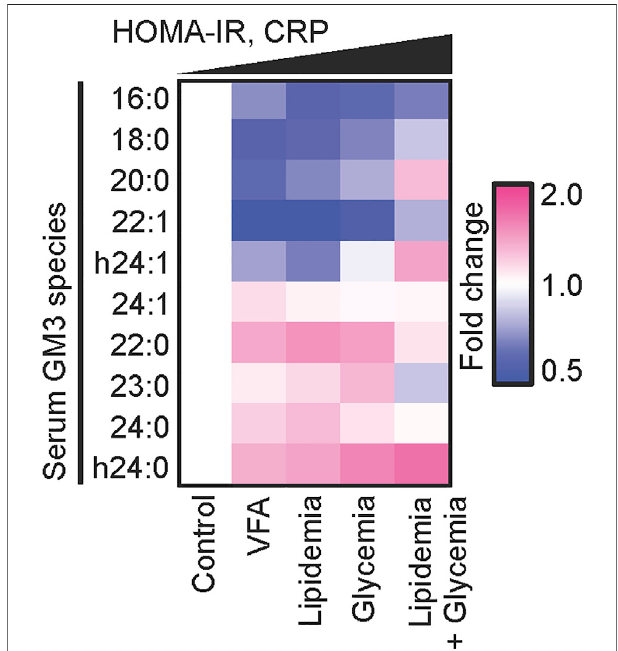
FIGURE 6 | Disease progression and chronic in fl ammation involve alterations of GM3 species composition. Heat map analysis of serum GM3 speciesinvariouspathologicalphases:control( n =24),VFA( n =38),lipidemia ( n = 28), glycemia ( n = 15), lipidemia + glycemia ( n = 17). Colors (key at right) indicate fold change average of each species relative to control (de fi ned as 1). Order of pathological phases corresponds to increments